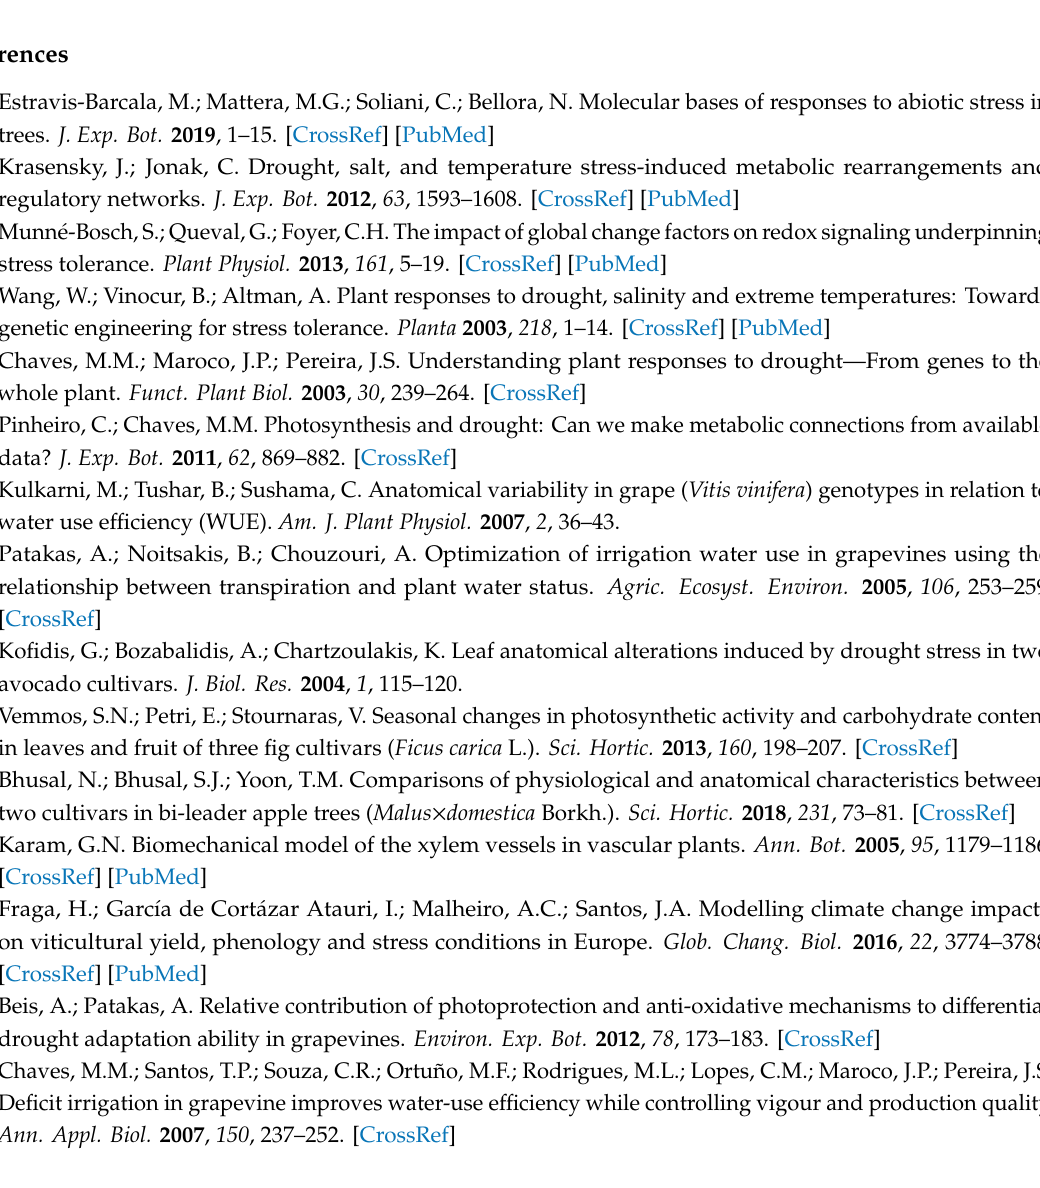
Figure S1: Mean temperature and relative humidity for outdoors and indoors (greenhouse) during the drought and heat stress experiment; Figure S2: Impact of short-term drought and heat stress on the content of phenols, flavonoids and antioxidant activity in two grapevine cultivars, Chardonnay and Xynisteri; Figure S3: Impact of short-term drought and heat stress on H 2 O 2 and malondialdehyde (MDA) contents, and activity of antioxidative enzymes in the leaves of two grapevine cultivars, Chardonnay and Xynisteri; Figure S4. Impact of short-term drought and heat stress on photosynthetic rate in two grapevine cultivars, Chardonnay and Xynisteri; Table S1: Soil physicochemical